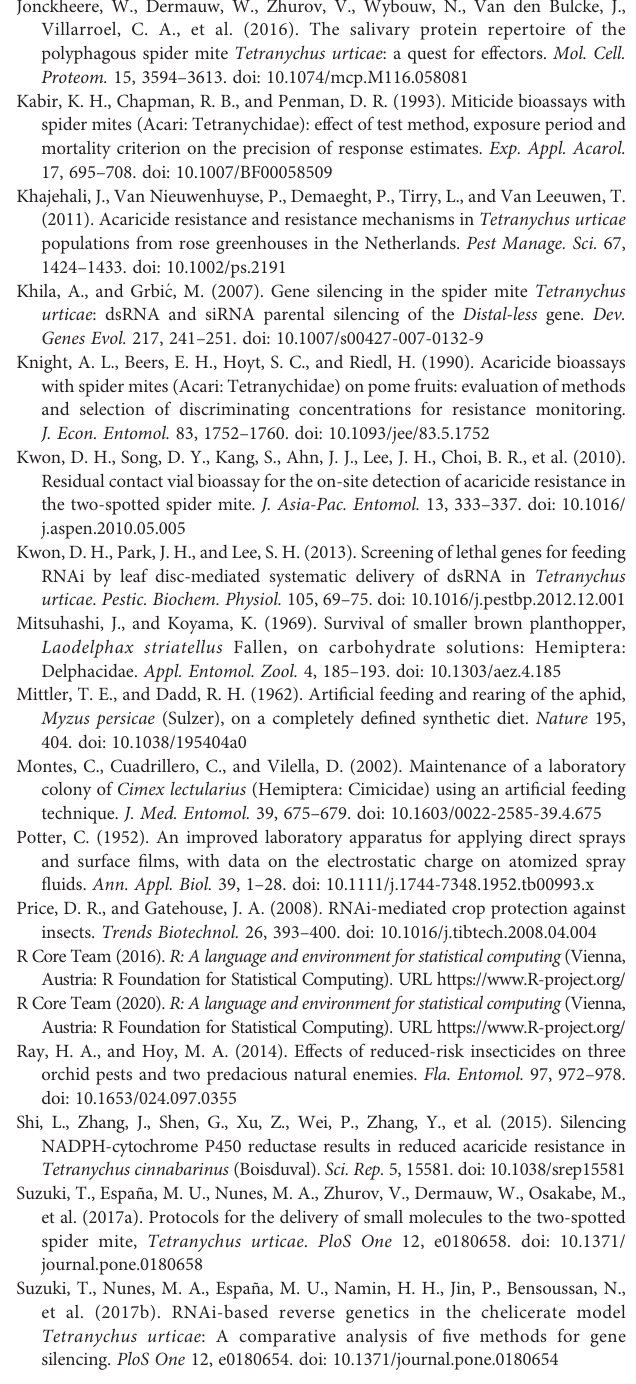
feeding device. The white arrowhead points at the stylets of the aphid. Scale bars: (A) 100 µm; (B, C) 500 µm. VIDEO S1 | Preparation of the feeding device in the mesh method. VIDEO S2 | Adult Tetranychus urticae females ( n ≈ 50) sucking on 1% (w/v) blue tracer dye (Brilliant Blue FCF) solution in the mesh method feeding device for 1.5 h. The video is shown at 64× speed. Feeding arena: 5 × 5 mm.